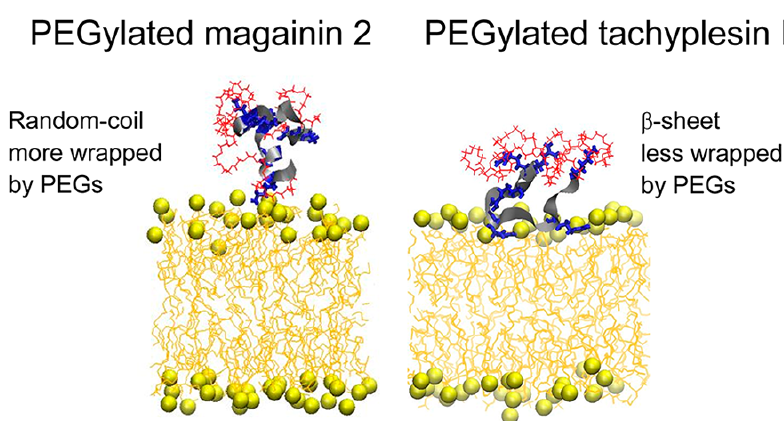
Figure 2. Snapshots of PEGylated magainin 2 (left) and tachyplesin I (right) binding to the bilayer surface. PEG chains, peptide backbones, and cationic residues of the peptide are colored in red, gray, and blue, respectively. (Reprinted with permission from [56]. Copyright 2013 American Chemical